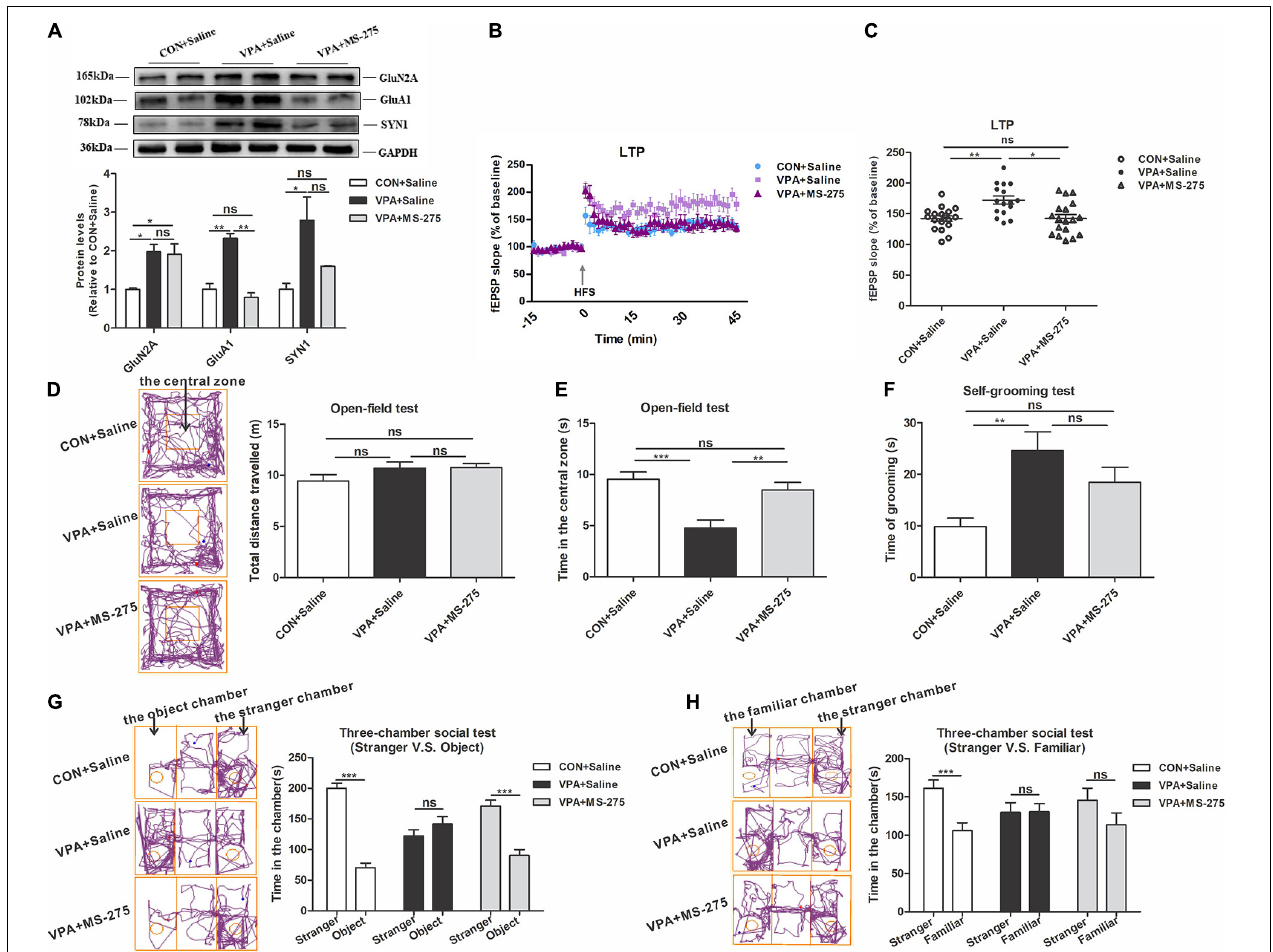
FIGURE 6 | Changes in homeostatic synaptic plasticity and autism-like behaviors in VPA-exposed offspring after MS-275 treatment. (A) Western blot and quantification analyses of GluN2A, GluA1, and SYN1 protein in the PFC of offspring from the CON + Saline, VPA + Saline, and VPA + MS-275 groups ( n = 3 per group). (B) Summary graphs of PFC LTP in the CON + Saline, VPA + Saline, and VPA + MS-275 groups ( n = 9 slices from 4 rats per group). (C) LTP magnitude was measured as an average potentiation at 41–45 min after the onset of HFS induction ( n = 9 slices from four rats per group). (D–H) Behavioral tests were performed in offspring from the CON + Saline, VPA + Saline, and VPA + MS-275 groups beginning at PND 43. (D) The tracing and total distance traveled in the open-field test ( n = 20–22 per group, F 2 , 60 = 1.788, P = 0.176). (E) The time spent in the central zone in the open-field test ( n = 20–22 per group, F 2 , 60 = 11.238, P <